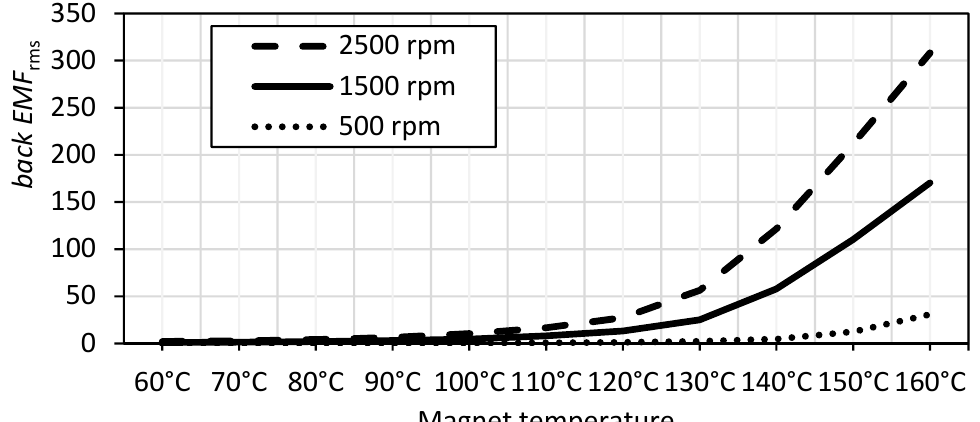
Figure 19. Back EMF difference (before and after the fault) at 3 different speeds.